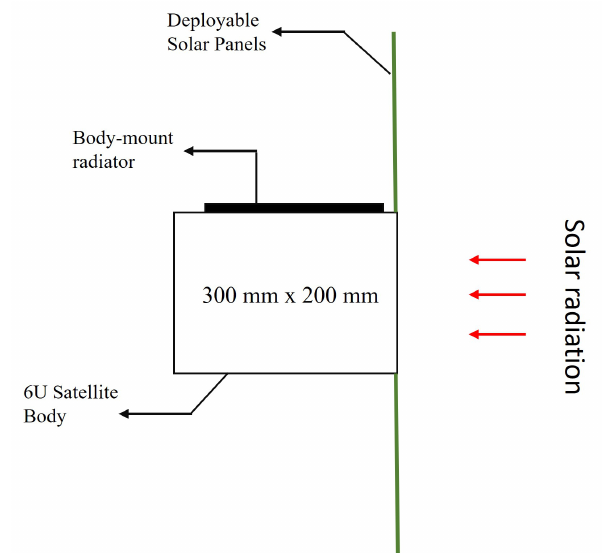
Figure 5. BMR-Satellite Orientation with respect to